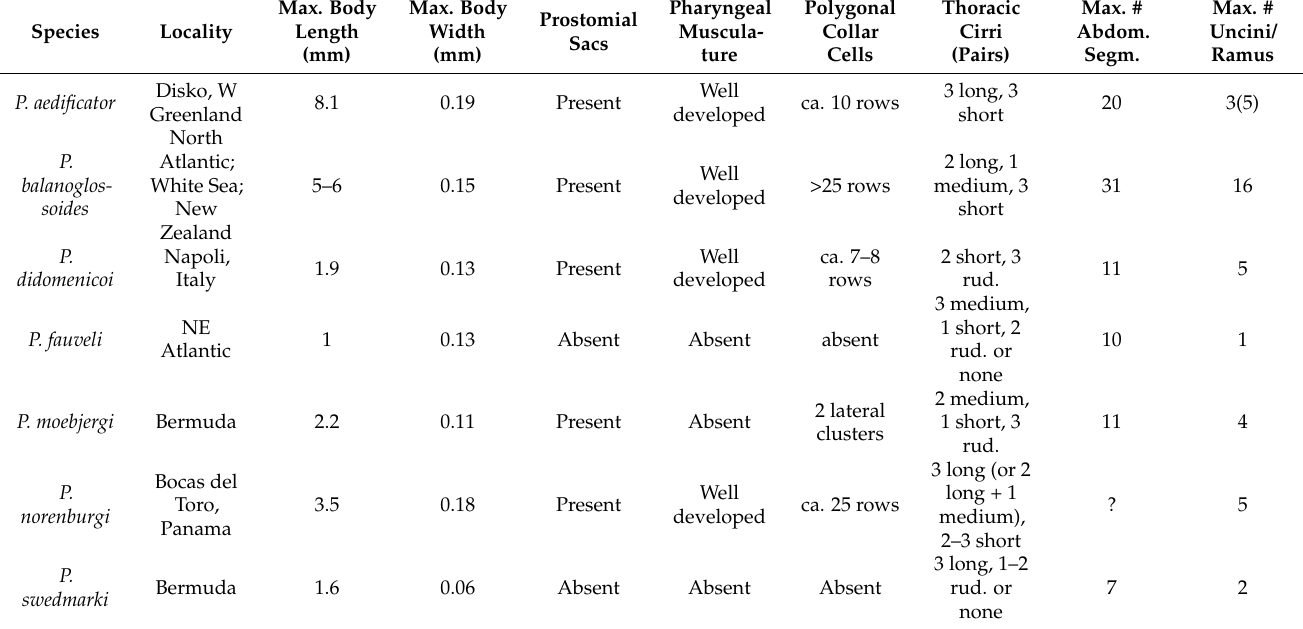
Table 3. List of main characters for the eight described species of Psammodrilidae (modified from [21]). Abbreviations: abdom., abdominal; max., maximum; rud., rudimental; segm., segment; #, number. Species